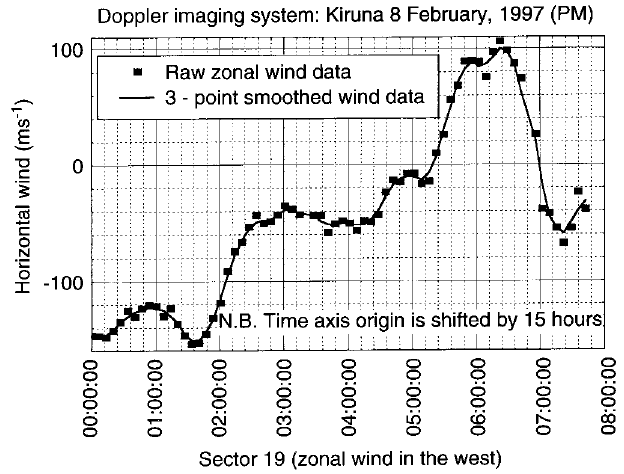
Fig. 10 The zonal wind measurement by DIS p.m. Feb 8 1997: Comparison between ( j ) raw and (—) smooth